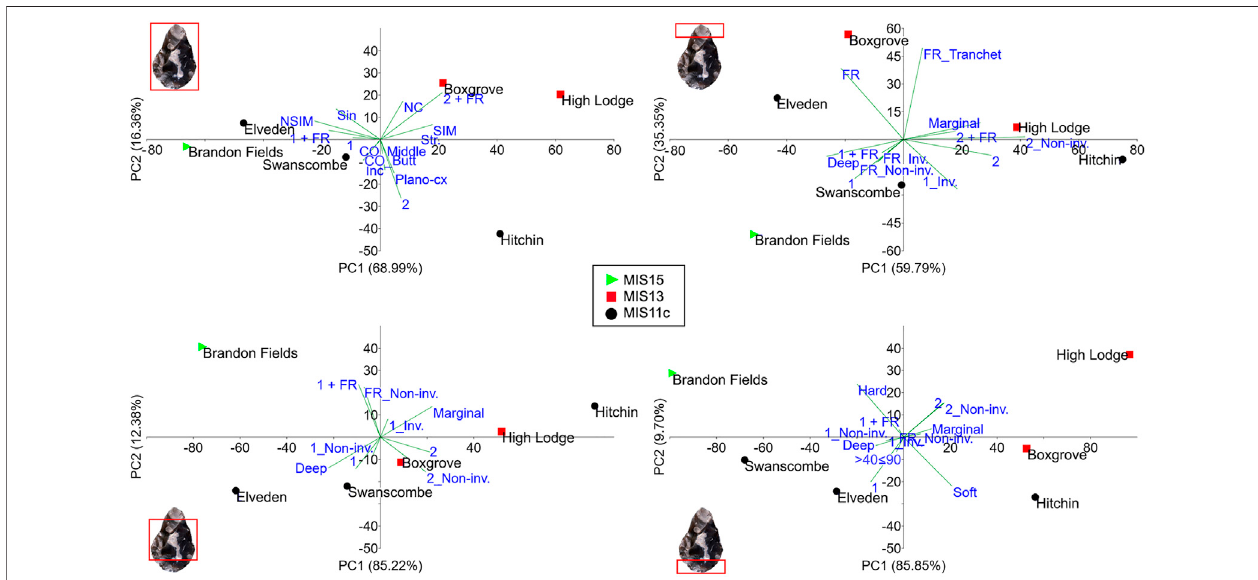
FIGURE 5 | PCA (biplots) of the technological features, which have a major effect on each group. The four graphs correspond with the technological variables includedin Figure4 butdividedin: (A) Generalaspects; (B) Distalpart; (C) Mid-part; (D) Proximalpart.Inblue,technologicalfeatureswhichcontributetothedistribution ofsites. Abbreviations:Hard, hard percussion; Soft,soft percussion;H/S, combined; 1, oneremoval series;2, tworemoval series;1+FR, one plus Final Retouch; 2+FR, twoplusFinalRetouch;CO_Butt,cortex inbutts; CO_Butt+Mid,cortexinbuttsandmid-parts;CO_All,cortexinthewholeinstrument;CO_Midddle, Cortexinthe mid-parts;NC,nocortex;Str,straightedges;Sin,sinuousedges;Inc,incurvededges;SIM,symmetricpro fi le;NSIM,non-symmetricpro fi le;Pl-cx,Plano-convexpro fi le; Deep,deepeffectonedges;Marginal,marginaleffectonedges;1_Inv., fi rstinvasiveremovalseries;1_Non-inv., fi rstnon-invasiveremovalseries;2_Inv.,secondinvasive removalseries;2_Non-inv.,secondnon-invasiveremovalseries;FR.Inv.,invasive FinalRetouch;FR. Non-inv.,non-invasiveFinalRetouch;FR_Tranchet, Distaltranchet Final Retouch).